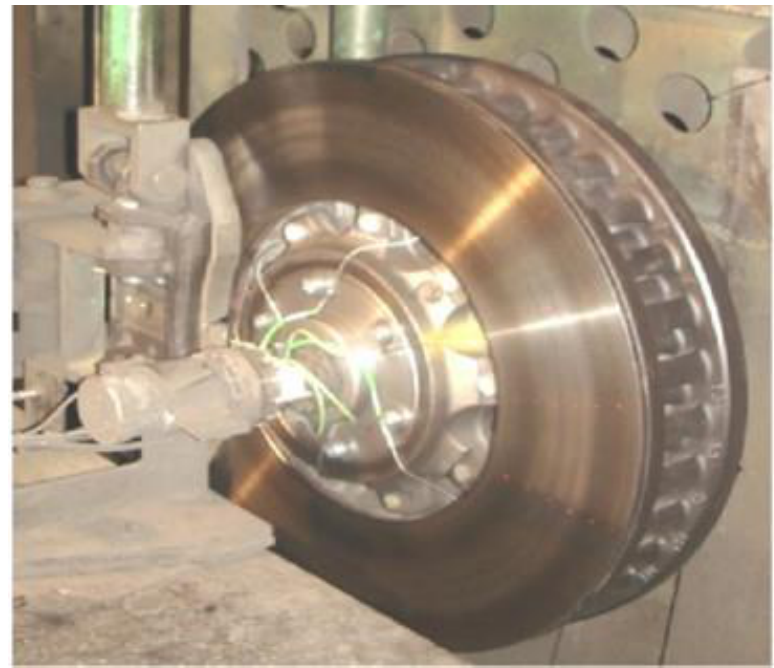
Figure 2. The disc brake machine used for measuring the wear rate and COF [73].